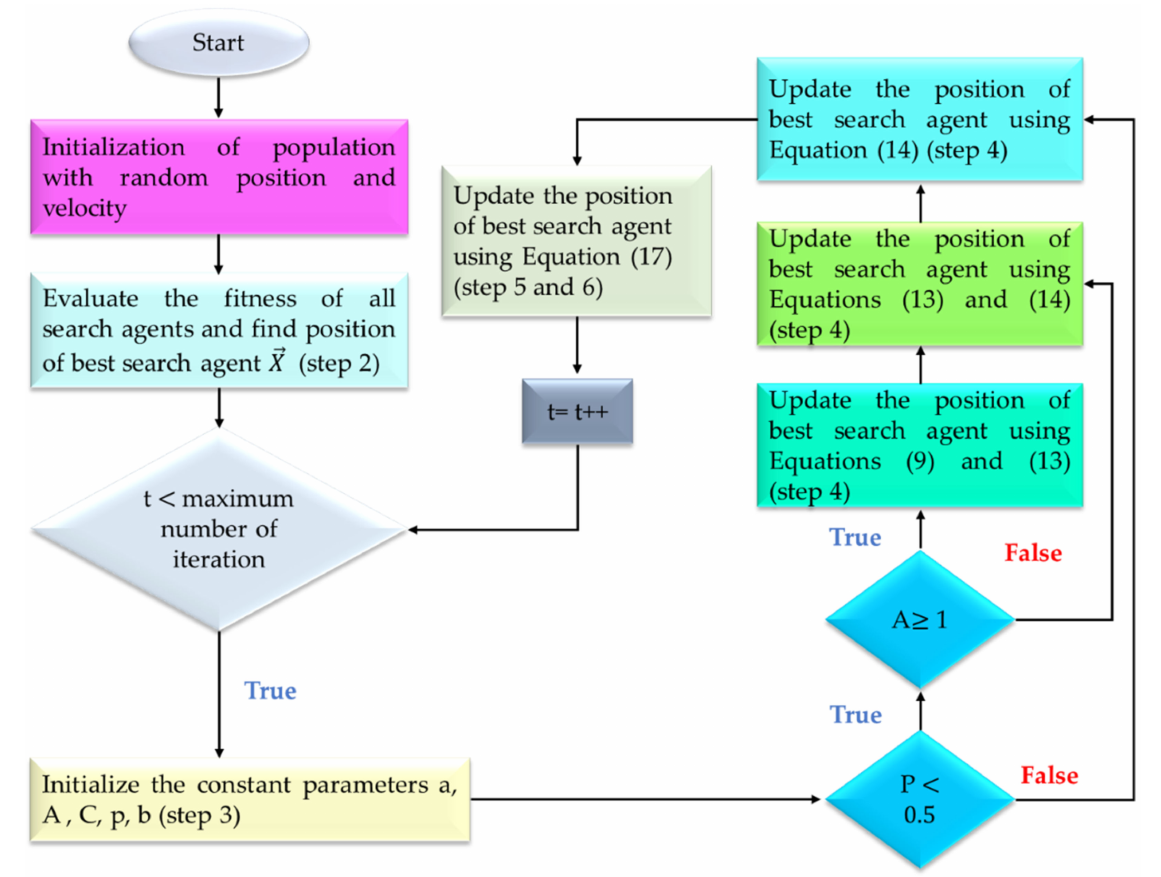
Figure 8. Flowchart of WOAPSO algorithm (reprinted from Ref.